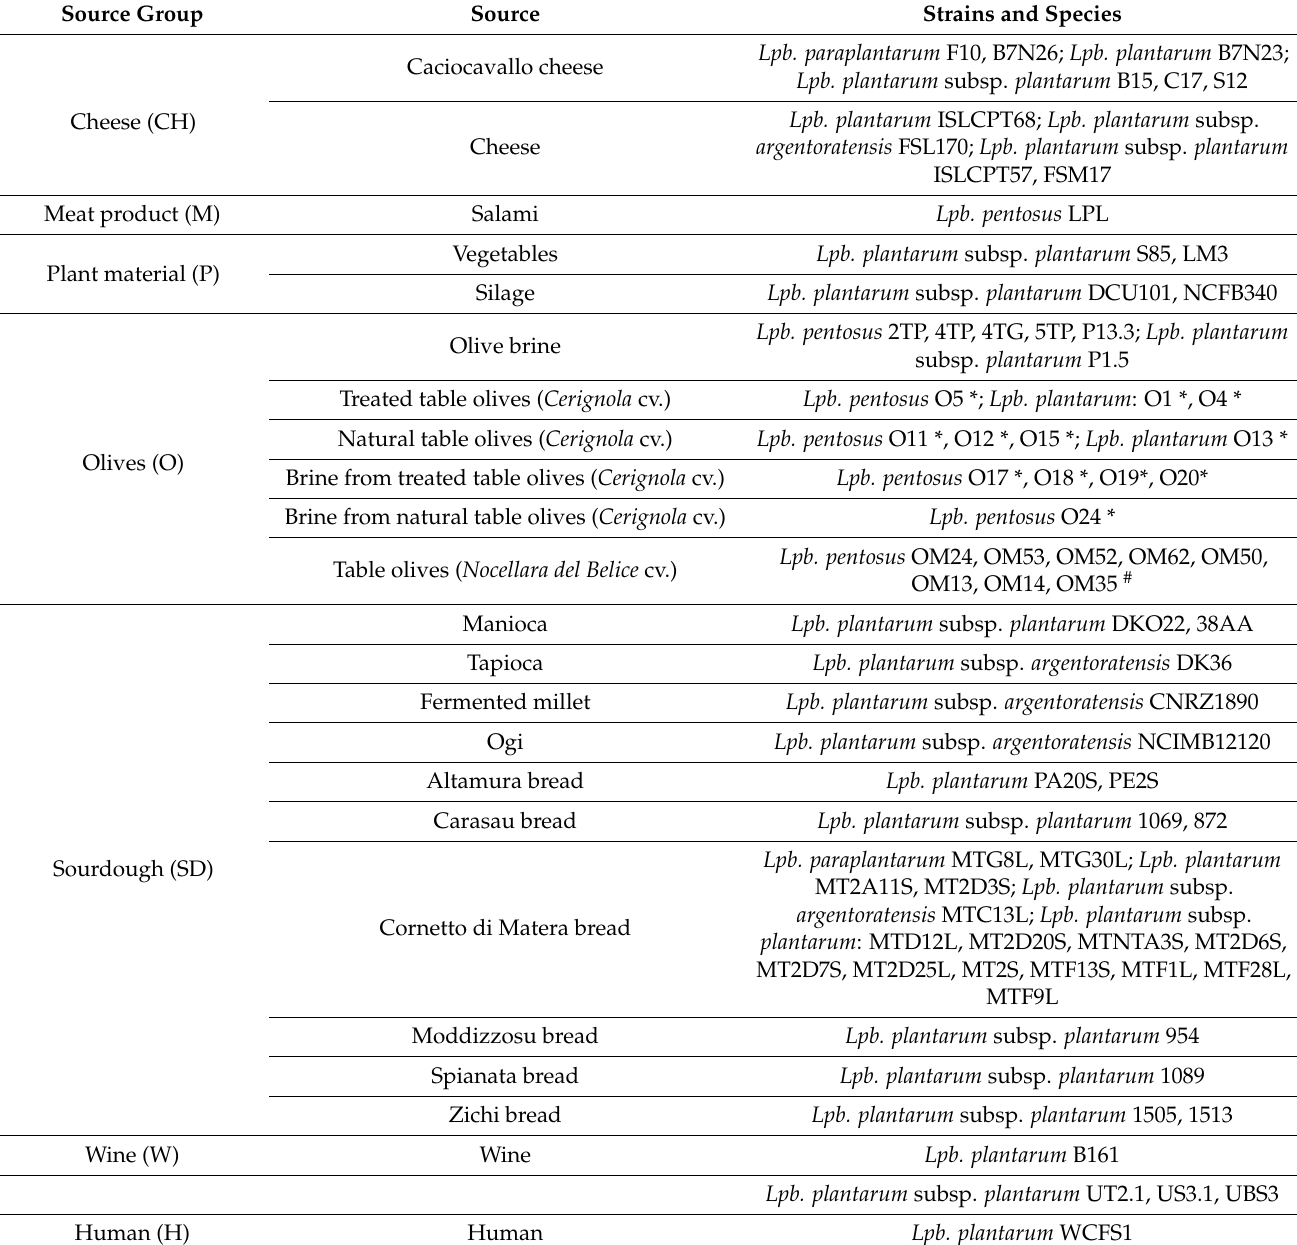
Table 1. List of Lactiplantibacillus strains used in this study.